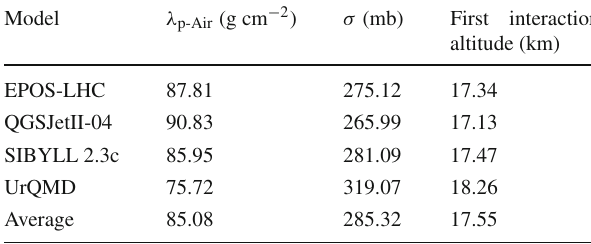
Table 2 First interaction results from 10 6 event simulations with